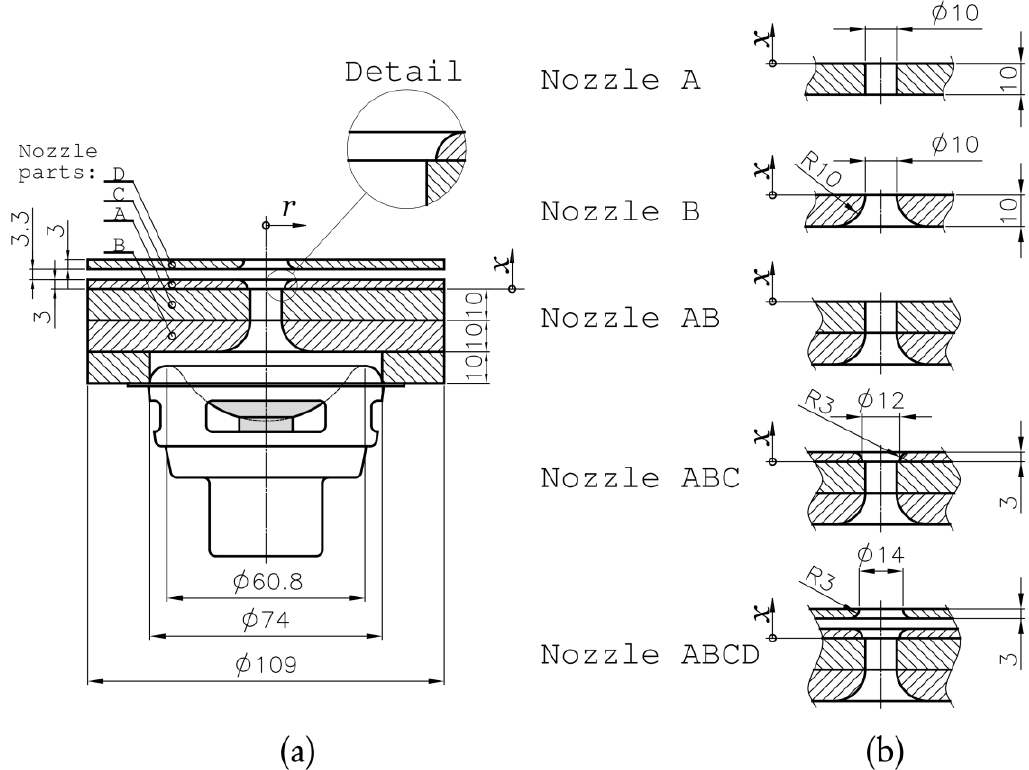
Figure 1. Experimental setup and methods (dimensions in millimeters): ( a ) synthetic jet actuator with nozzle ABCD mounted, ( b ) shapes of the tested nozzles.